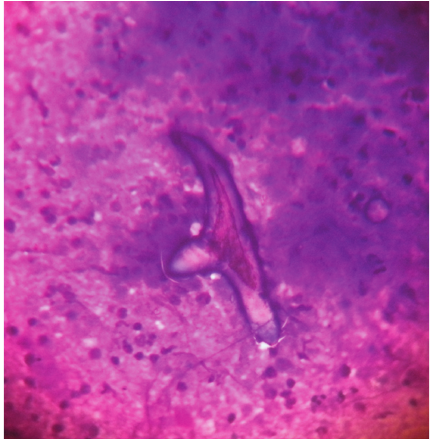
Figure 1: Showing hooklet of cysticercus in an inflammatory